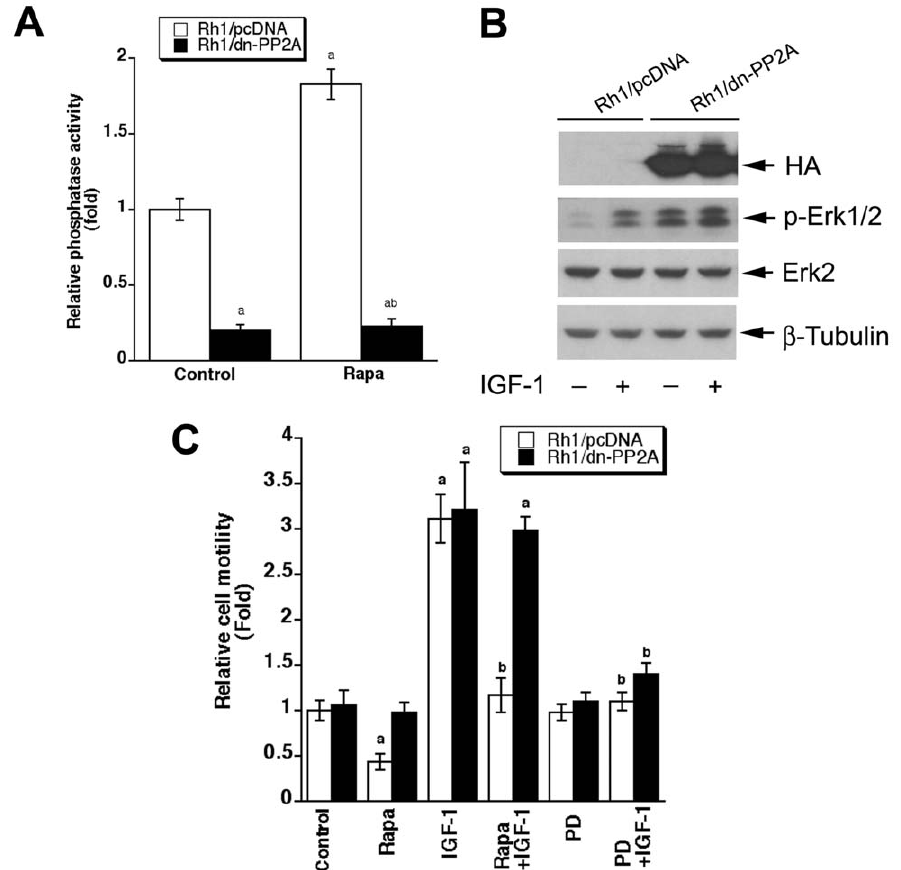
Figure 4. Expression of dominant negative PP2A confers resistance to rapamycin inhibition of cell motility. (A) Rh1 cells were stably transfected with vector alone (Rh1/pcDNA) or with a vector expressing HA-tagged dn-PP2Ac (L199P), serum-starved for 24 h, and then treated with or without rapamycin (Rapa, 100 ng/ml), followed by in vitro phosphatase assay using Ser/Thr Phosphatase Assay Kit 1 (Millipore). Data represent mean 6 SE from 3–4 independent experiments. a P , 0.05 vs. Rh1/pcDNA control, b P , 0.05 vs. Rh1/pcDNA Rapa group. (B) Serum-starved Rh1/pcDNA and Rh1/dn-PP2A cells were stimulated with or without IGF-1 (10 ng/ml) for 15 min, followed by Western blotting using the indicated antibodies. (C) Motility of Rh1/pcDNA and Rh1/dn-PP2A cells was determined by the wound healing assay, as described in Materials and Methods . Serum-starved cells were pretreated with or without rapamycin (Rapa, 100 ng/ml) or PD98059 (PD, 10 m M) for 2 h, and then stimulated with or without IGF-1 (10 ng/ ml) for 22 h. Results are means 6 SE of 3–4 independent experiments. a P , 0.05, difference vs. control group; b P , 0.05, difference vs. IGF-1